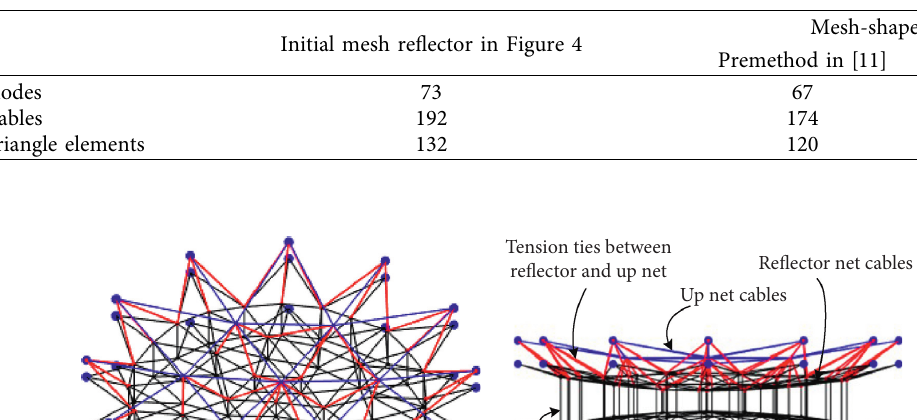
Figure 8: Surface nodal deviations of the mesh-shaped reflector. (a) In the oxy plane. (b) In the z -direction. Table 3: Mesh complexity comparison of the mesh reflectors before and after topology design.